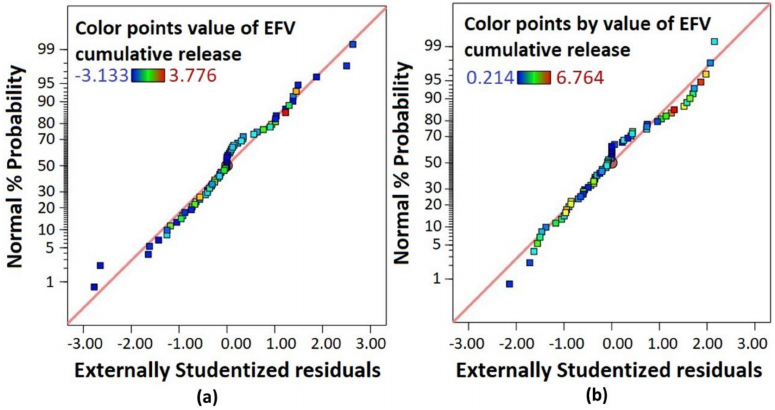
Figure 13. Normal plot of residuals for EFV-LNC ( a ) and for free EFV ( b